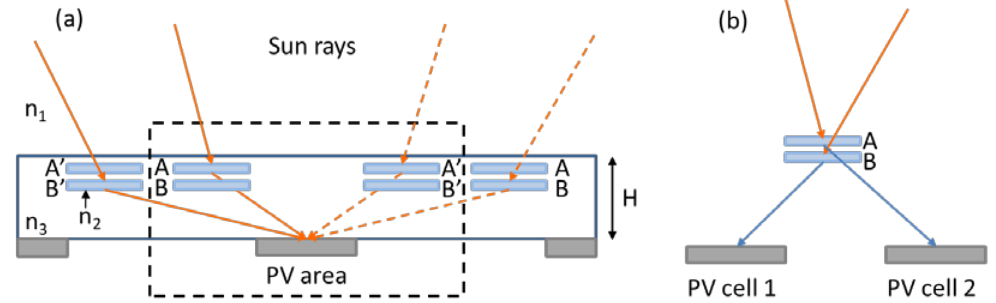
Figure 4. ( a ) Holographic solar concentrator structure realized by Castro et al. [9]. In the dashed box the unit cell is highlighted. ( b ) Holographic design to reduce the optical the unit cell is highlighted. ( b ) Holographic design to reduce the optical crosstalk.